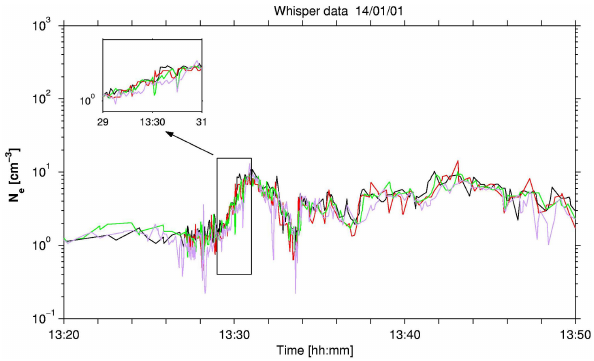
Fig. 18. Magnetospheric plasma density derived from measure- ment of the local plasma frequency by the WHISPER experiment on all four Cluster spacecraft for the key interval between 13:20 and 13:50 UT. Here we use the standard Cluster spacecraft colour- coding, which is black, red, green and magenta for spacecraft1, 2, 3, and 4, respectively. The inserted blowup around 13:30 UT allows for the identification of the temporal sequence of satellite encoun- ters with an increase in the plasma density.